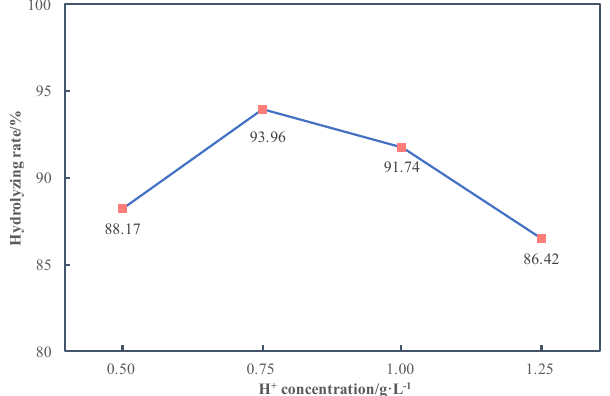
Figure 7. Effect of H + concentration on hydrolyzing rate of titanium.